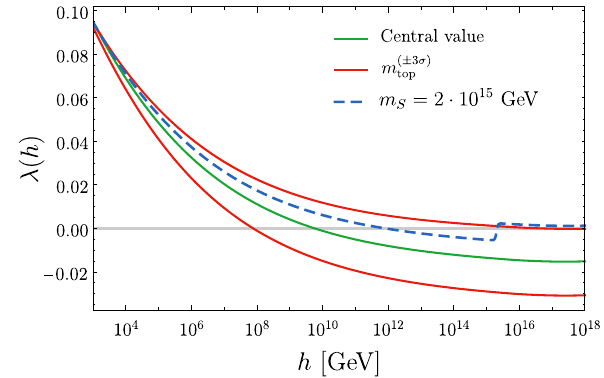
Fig. 1 RunningoftheHiggsquarticcoupling λ withtheintroductionof an extra scalar(dashed blue line), together with the central and marginal values within the SM [11–13]